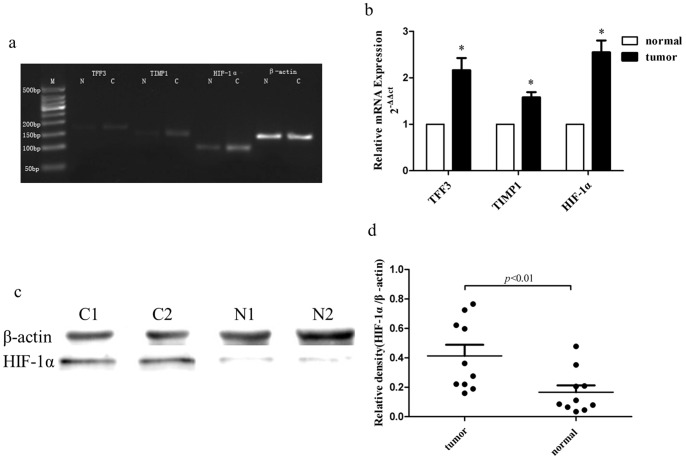
Validation of overexpression of HIF-1α, TIMP1 and TFF3 in 10 pairs of gastric cancer vs. normal tissues.a and b, Detection of HIF-1α, TIMP1 and TFF3 mRNA expression in gastric cancer vs. normal tissues using PCR and qRT-PCR. Levels of HIF-1α, TIMP1, TFF3 mRNA were 2.55±0.56, 1.58±0.25, 2.16±0.59 folds up-regulated in tumor tissues, respectively compared to those of the normal ones. *p<0.01. c and d, Western blot analysis of HIF-1α protein. Tumor tissues expressed higher level of HIF-1α protein compared to the normal ones [p<0.01 (d). N, normal tissues; C, cancer tissues (c)].